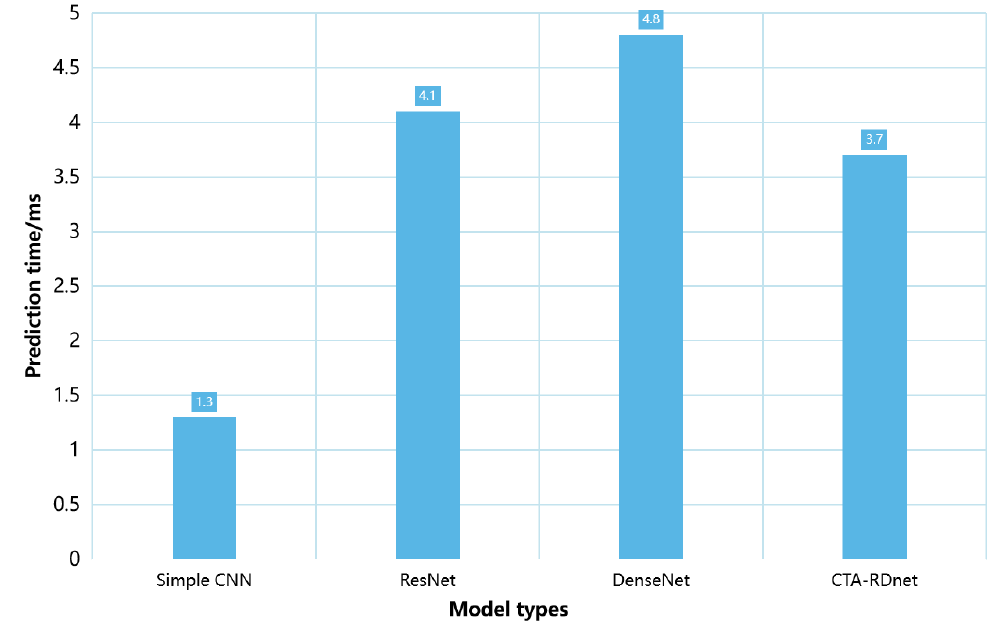
Figure 12. Prediction time of each